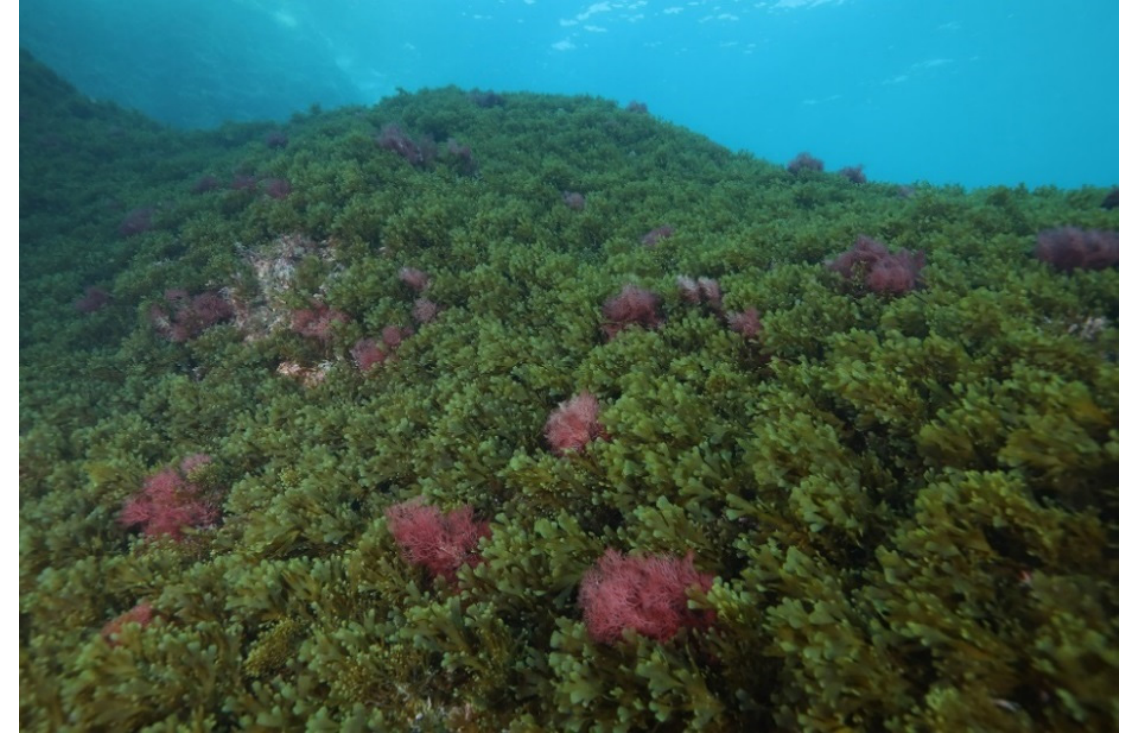
Figure 3. A rocky reef carpeted with Rugulopteryx okamurae in February 2019. Red seaweeds are Sphaerococcus coronopifolius Stackhouse, a native species. Photo © Sandrine Ruitton.